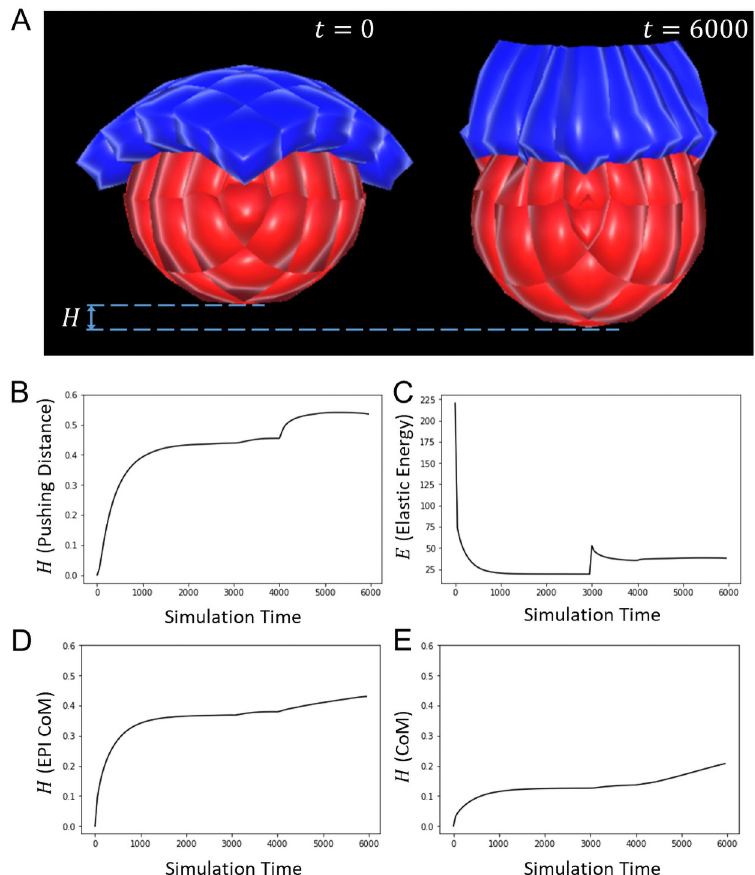
Fig 5. Trophectoderm fosters epiblast movement towards maternal sites. A . Snapshots of the simulation of TE and EPI morphogenesis during mouse implantation, and their influence on EPI positioning, taken respectively at t = 0 and 6000. B . Plot of the pushing distance, which increases with time. C . Plot of the elastic energy E . Discontinuities mark the start of new morphological events ( t = 0 and 3000). The sudden soar observed at t = 4000 reflects the slight elongation of the tissue due to hollowing-driven lumenogenesis in the epiblast. D . Plot of the pushing distance on the epiblast Centre of Mass (CoM), which also increases with time. E . Plot of the pushing distance on the cell population Centre of Mass (CoM), which also increases with time. Values of the equation parameters: J EPI = J TE = 2.5, λ med = λ χ = 2, ρ = 1, d = 0.5, R lum = 0.25.